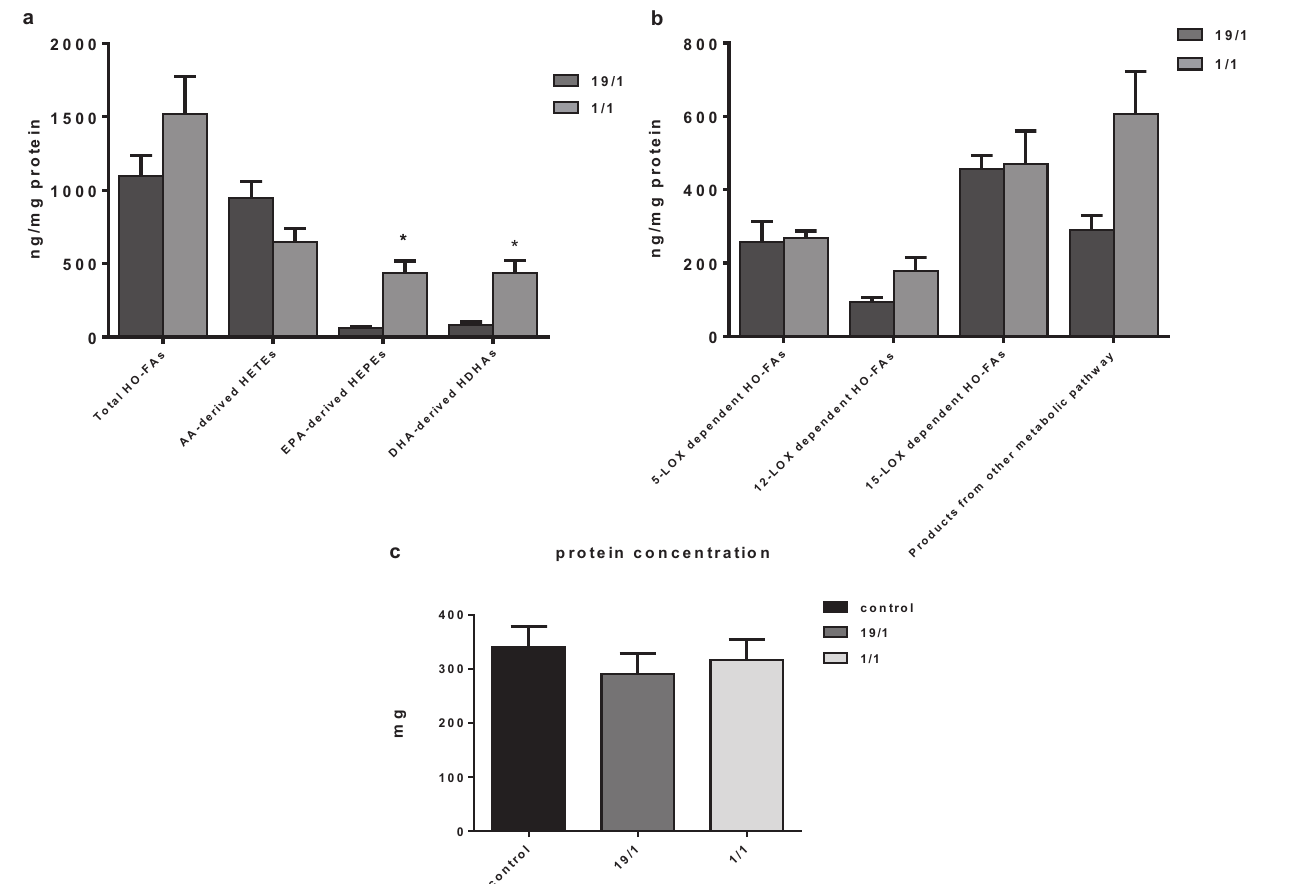
Figure 1. Comparison of metabolites derived from arachidonic acid (AA)/eicosapentaenoic acid (EPA)/docosahexaenoic acid (DHA), in response to incubation of THP-1 macrophages with a high ratio of AA/(EPA+DHA) (19/1) vs. a low ratio of AA/(EPA+DHA) (1/1). ( a ) Total monohydroxylated fatty acids (HO-Fas) and those derived from AA/EPA/DHA respectively; ( b ) HO-FAs formed by combined action of 5-,12-, 15- Lipoxygenase (LOX), and the other metabolic pathways or autooxidation. * p < 0.05, ** p < 0.01 1/1 vs. 19/1 ratio; ( c ) There was no significant difference in THP-1 macrophage growth between the two groups during the 6 h polyunsaturated fatty acid (PUFA) incubation as evidenced by similar total protein content in the cell pellets ( p = 0.7 for 19/1 vs.